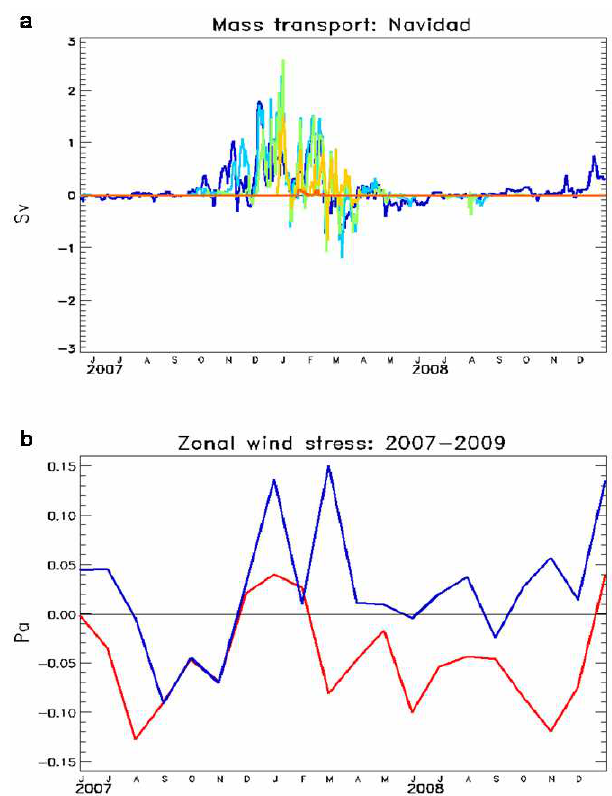
Fig. 18. (a) Transport (Sv) of the poleward flow for water mass warmer than 13.0 ◦ C and saltier than 35.7psu at 43.24 ◦ N (blue), Figure 18: (a) Transport (Sv) of the poleward flow for water mass warmer than 13.0°C and saltier 7.61 ◦ W (turquoise blue), 6.2 ◦ W (green), 3.8 ◦ W (yellow) and than 35.7 psu at 43.24°N (blue), at 7.61°W (turquoise blue), at 6.2°W (green), at 3.8°W (yellow) 44.4 ◦ N (orange). (b) Meridional wind stress τ y (Pa) off western and at 44.4°N (orange). (b) Meridional wind stress τ y (Pa) off western Iberia (red) and of the zonal Iberia (red) and of the zonal wind stress τ x off northern Iberia wind stress τ x off northern Iberia (blue). Boxes chosen for the spatial average of τ x and τ y have (blue). Boxes chosen for the spatial average of τ x and τ y have been been chosen following the study of Le Cann and Serpette (2009). chosen following the study of Le Cann and Serpette